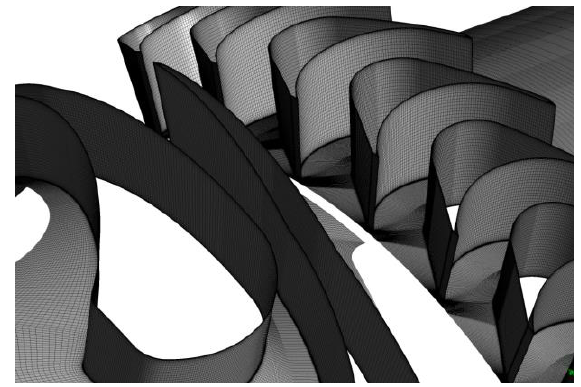
Fig. 4. Close-up onto the generated mesh of the stator-rotor interface.